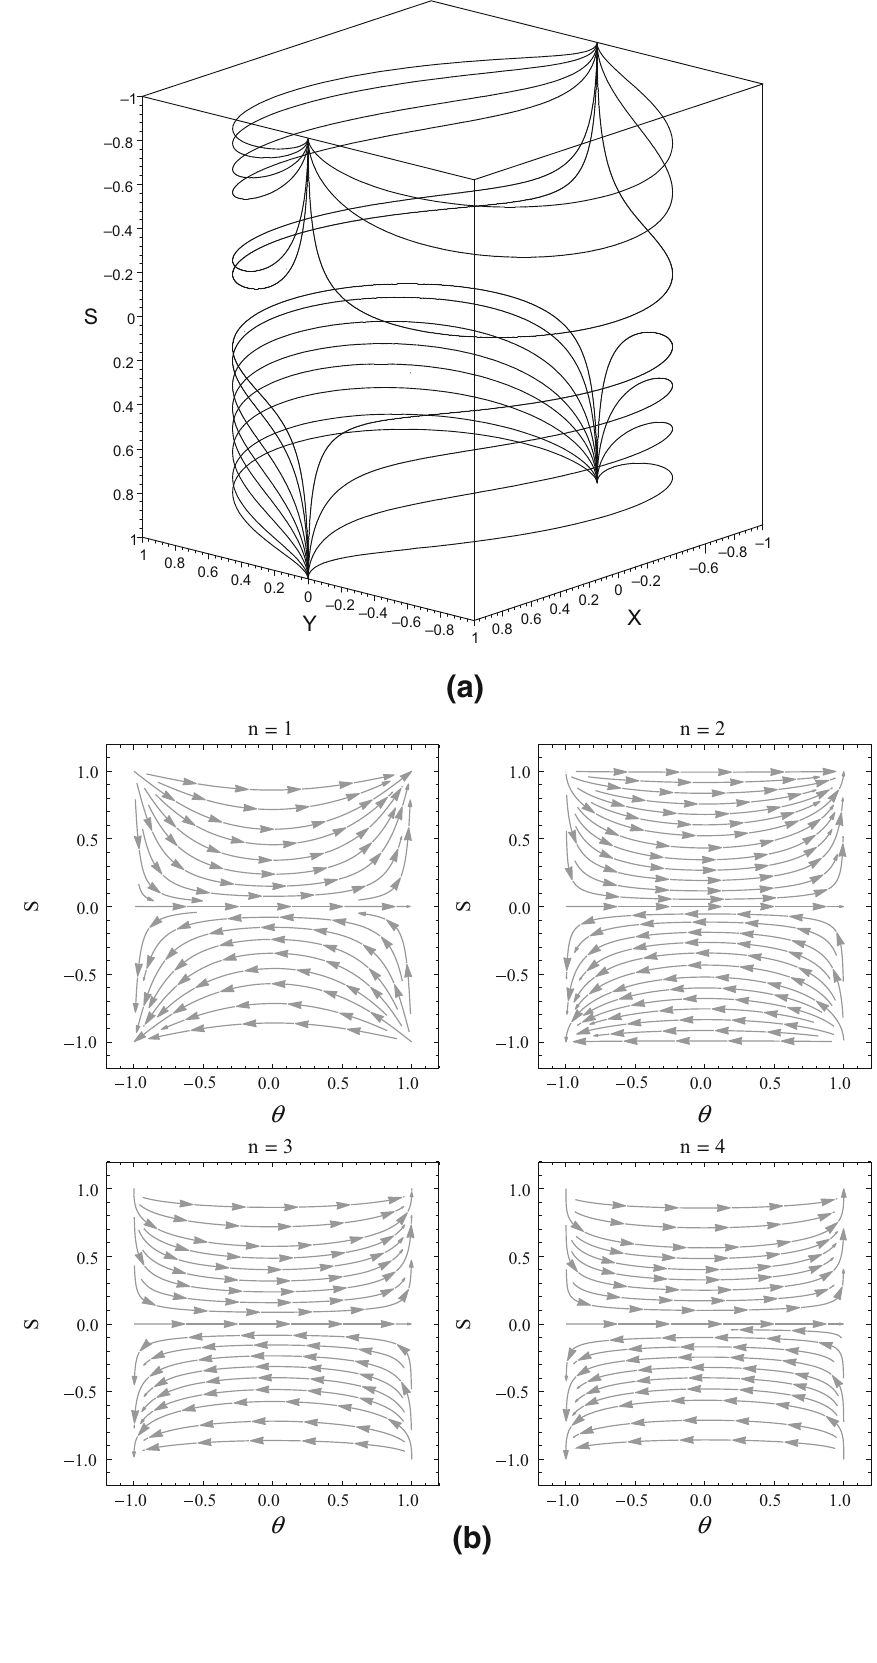
Fig. 15 a Compact phase portrait of (338), (339), (340) for the choice n = 2. b Dynamics on the cylinder at infinity given by Eqs. (342), (343) for some values of